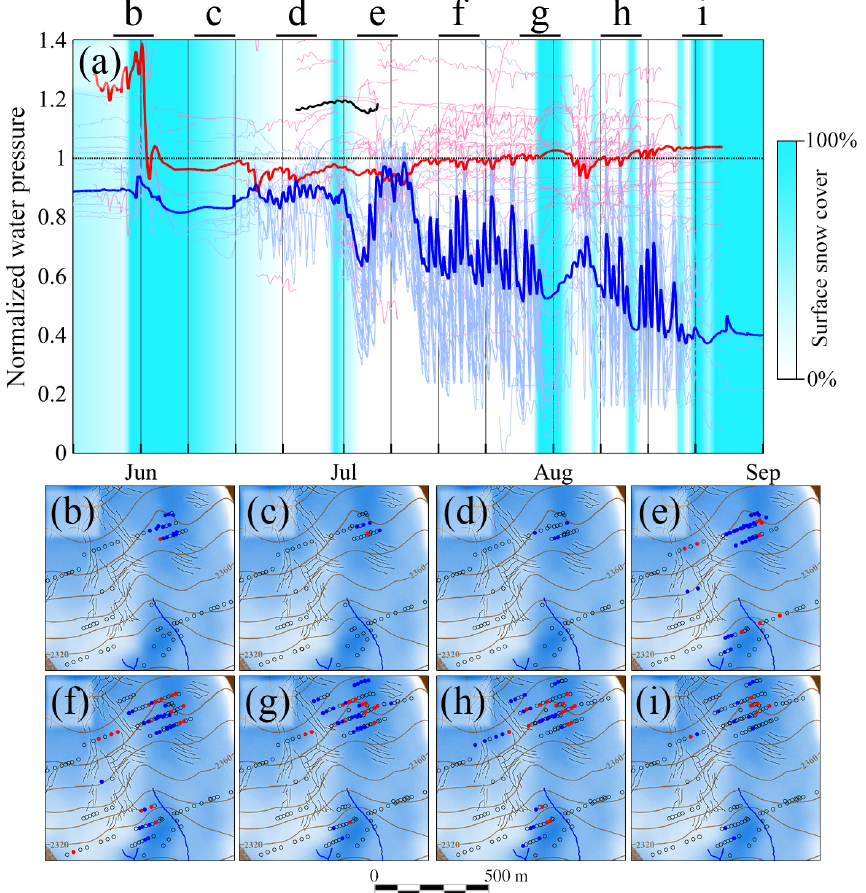
Figure 10. (a) Water pressure as a fraction of overburden for all correlated (blue) and anti-correlated (red) sensors participating in cluster H1. Thick lines represent mean values. The black line highlights a high-pressure correlated sensor, and the light blue shading represents the fraction of the glacier covered by fresh snow. Panels (b) to (i) show snapshots of the spatial distribution of correlated (blue circles) and anti-correlated (red circles) boreholes in eight time windows. Empty circles represent other boreholes that were recording water pressure at that moment. The extent of the time windows associated with each snapshot is shown by the black bars at the top of panel (a) . The blue shading represents ice